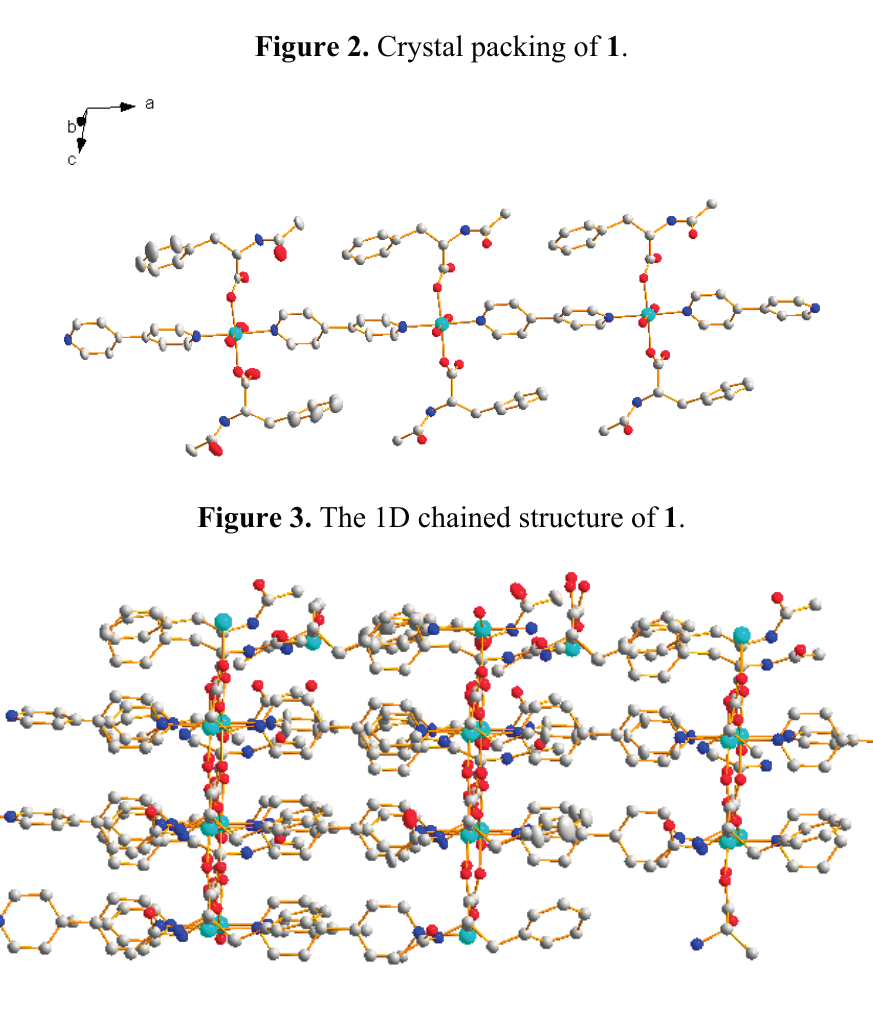
Figure 4. The 3D structure of 1